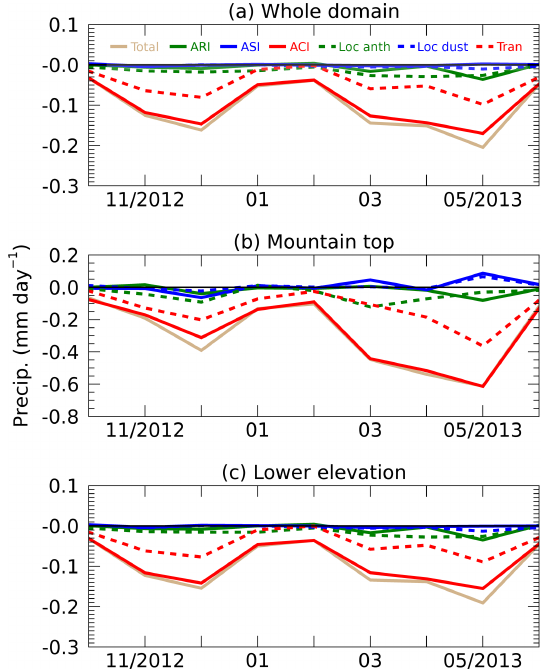
Figure 14. Monthly mean differences in precipitation (mmday − 1 ) due to total aerosols (brown solid), ARI (green solid), ASI (blue solid), ACI (red solid), local anthropocentric aerosols (green dashed), local dust (blue dashed), and transported aerosols (red dashed) averaged over (a) the whole domain (34–42 ◦ N, 117– 124 ◦ W, not including ocean points), (b) mountaintops (with eleva- tion ≥ 2.5km), and (c) lower elevation area (<2.5km) from October 2012 to June 2013. Zero line is shown as a thin black